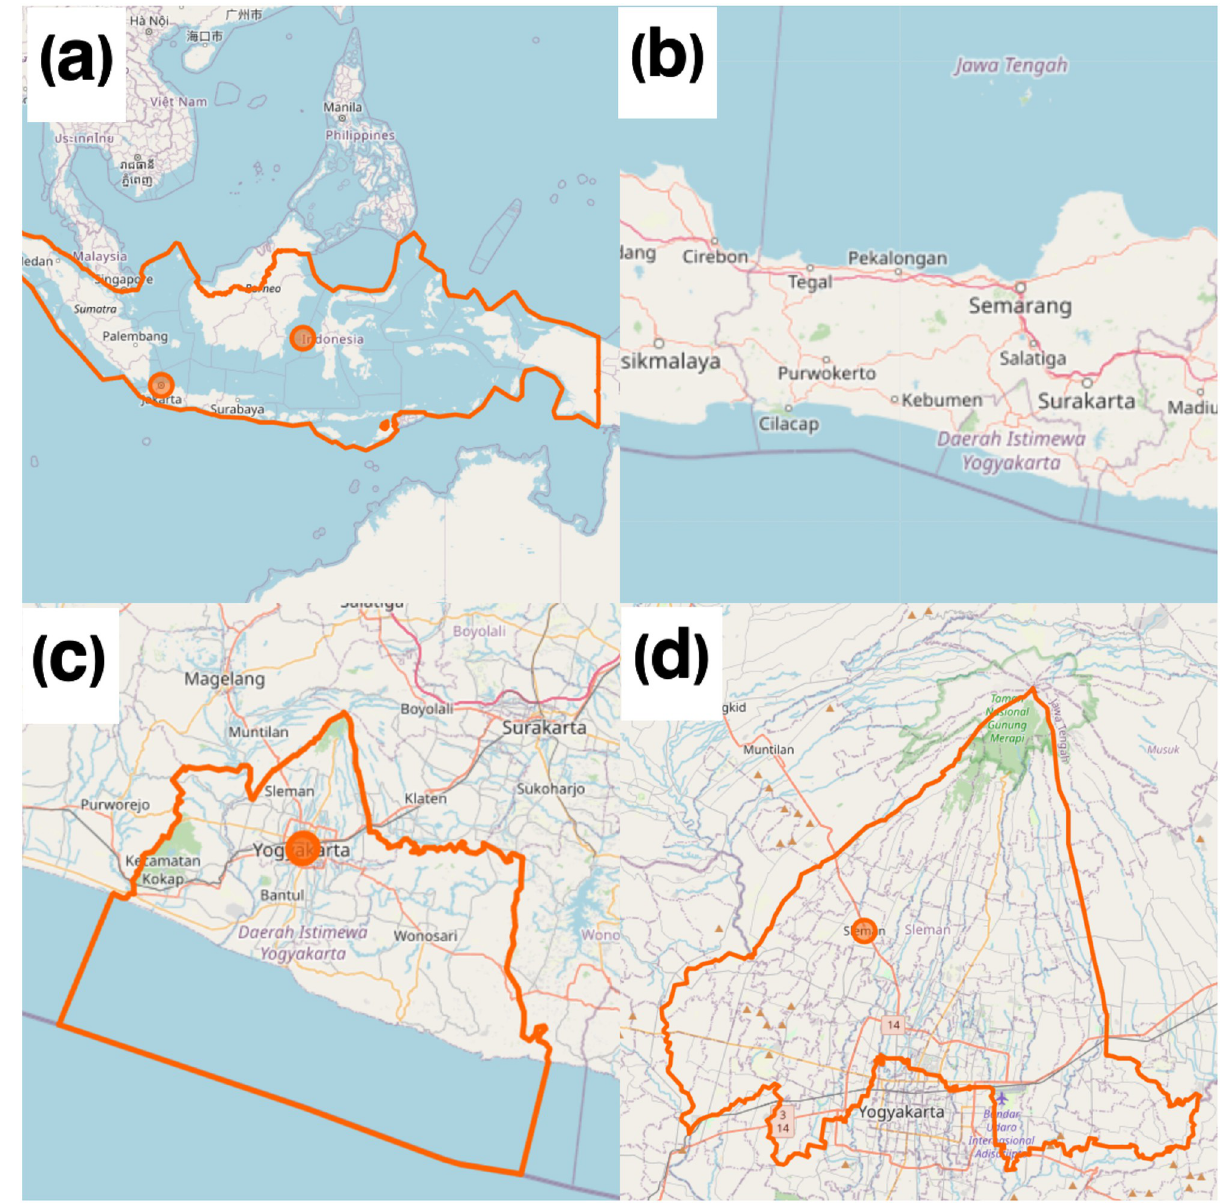
Fig 1. Location of the research. (a) the country of Indonesia (b) the island of Java (c) Yogyakarta province, and (d) Sleman regency © OpenStreetMap Contributor. This map is licensed under the Creative Commons Attribution-Share Alike 2.0 License (CC BY-SA). For further information, please visit http://www.openstreetmap.org/copyright.